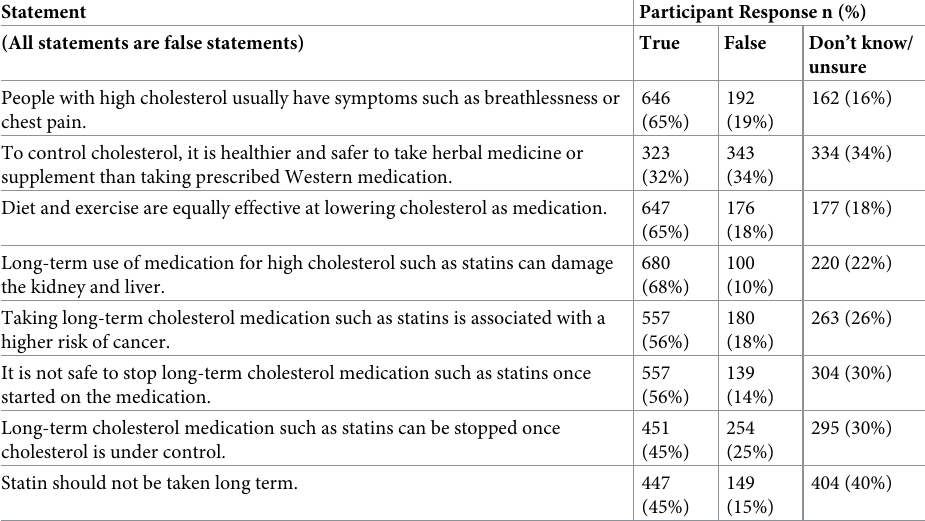
Table 2. Level of knowledge on cholesterol and its management (n =